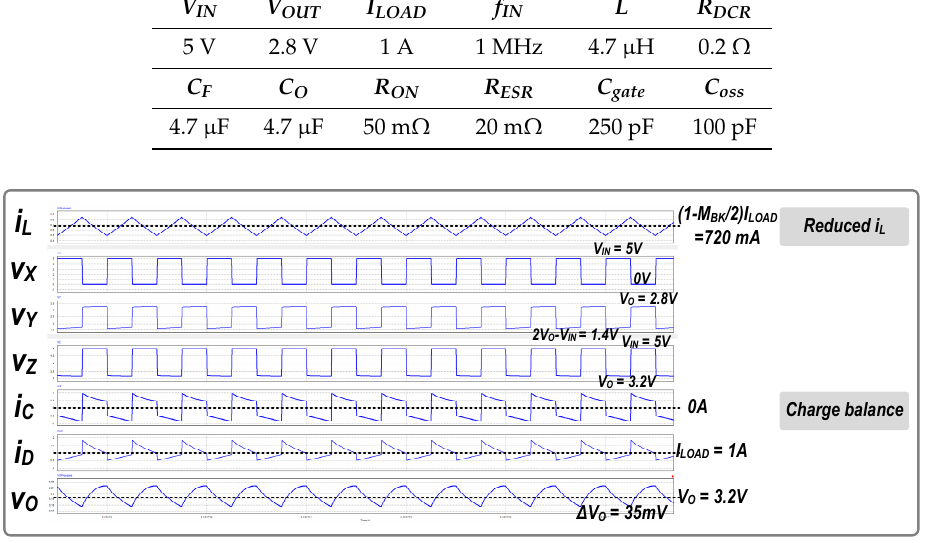
Table 1. Simulation conditions for buck converter with ETM.